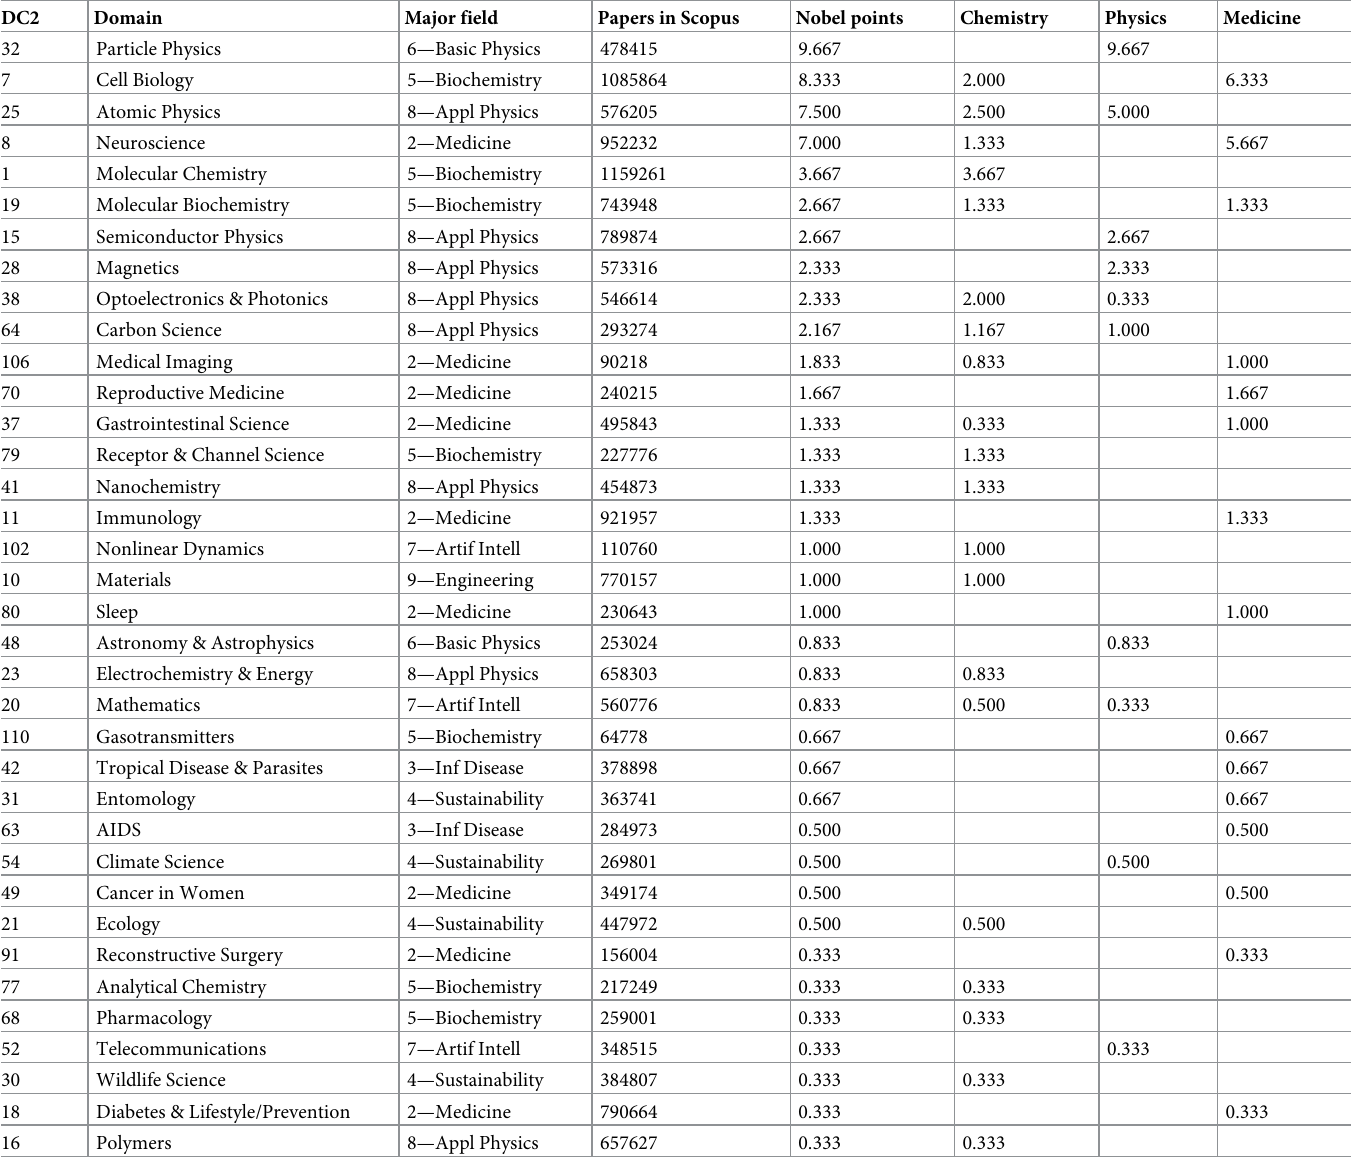
Table 1. The 36 domains that have been touched by at least 1 key paper from a Nobel prize �